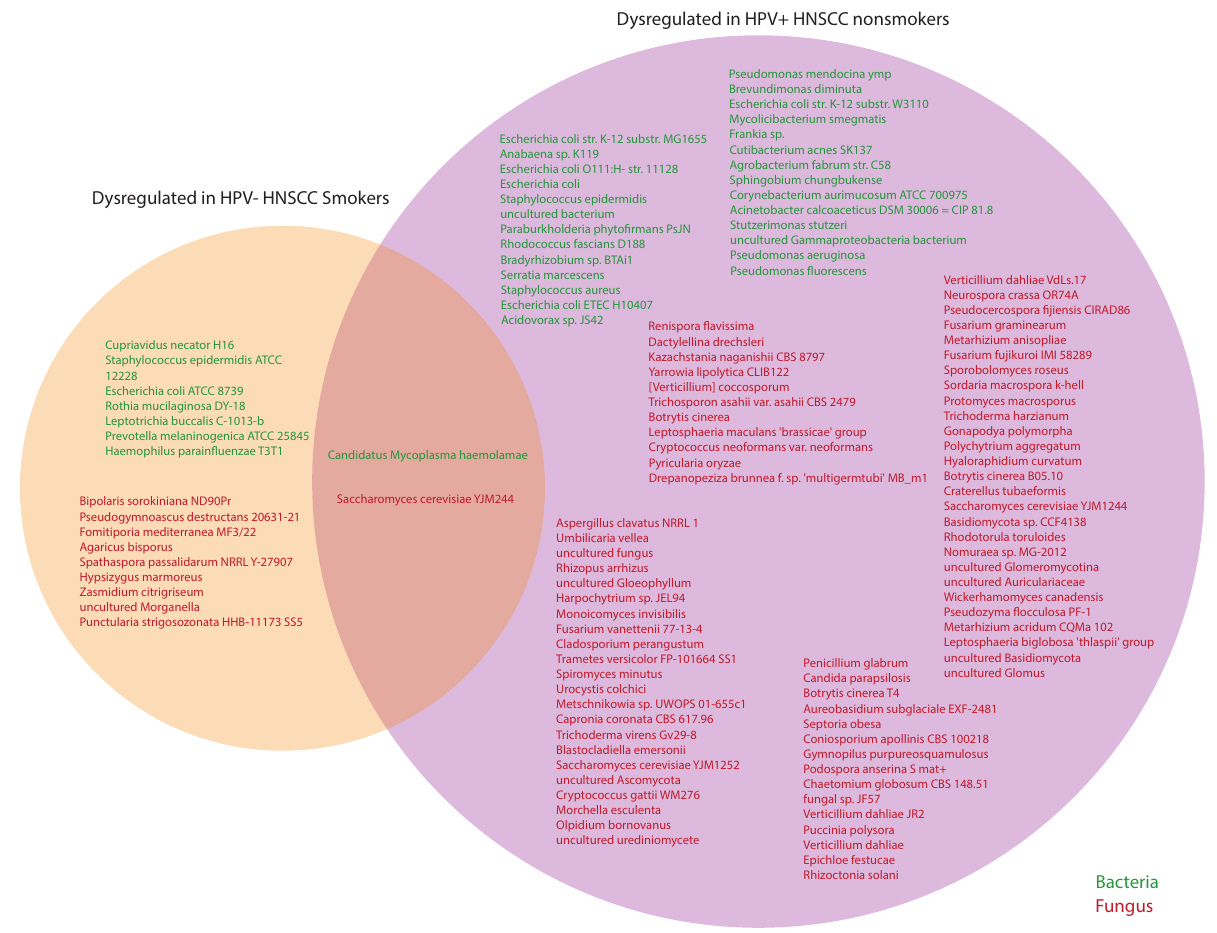
Figure 6. Dysregulation of microbes in HPV- smokers and the HPV+ tumor samples. Venn diagram comparing significantly dysregulated microbes in HPV- HNSCC smokers and HPV+ tumor samples. Green microbes represent bacteria, while red microbes represent fungi. The bacteria Candidatus Mycoplasma haemolamae and the fungus Saccharomyces cerevisiae YJM244 were common to both HPV+ HNSCC nonsmokers and HPV- HNSCC